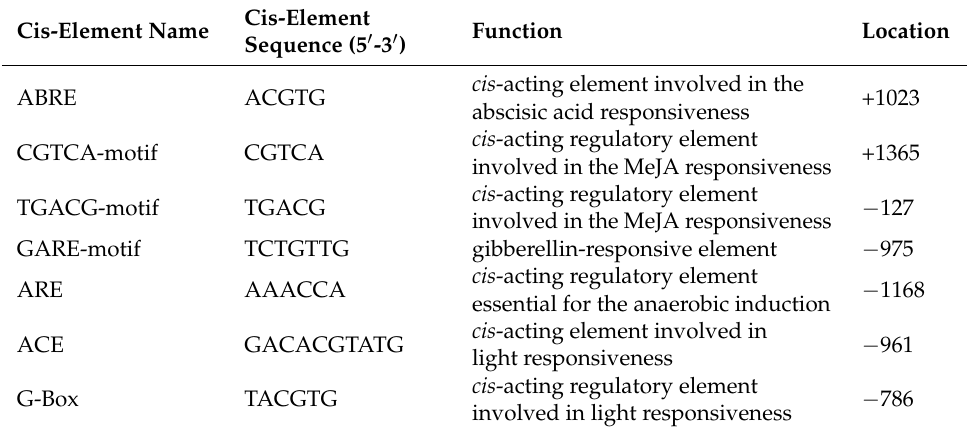
Figure 3. Expression patterns of MdLOX3 . ( A ) Expression pattern of MdLOX3 in different tissues of apple (roots, stems, leaves, flowers, peel, and flesh). Apple seedlings were treated with 150 mM of NaCl ( B ); 10% PEG6000 ( C ); and 100 μm of ABA ( D ) for 0, 1, 3, 6, and 12 h, respectively. Error bars, ± SD of three independent replicates. Different lowercase letters represent significant differences ( p < 0.05). Table 1. Promoter cis-elements analysis of MdLOX3